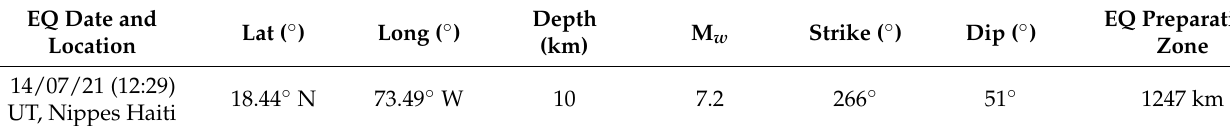
Table 1. Detailed information about the Haiti EQ.